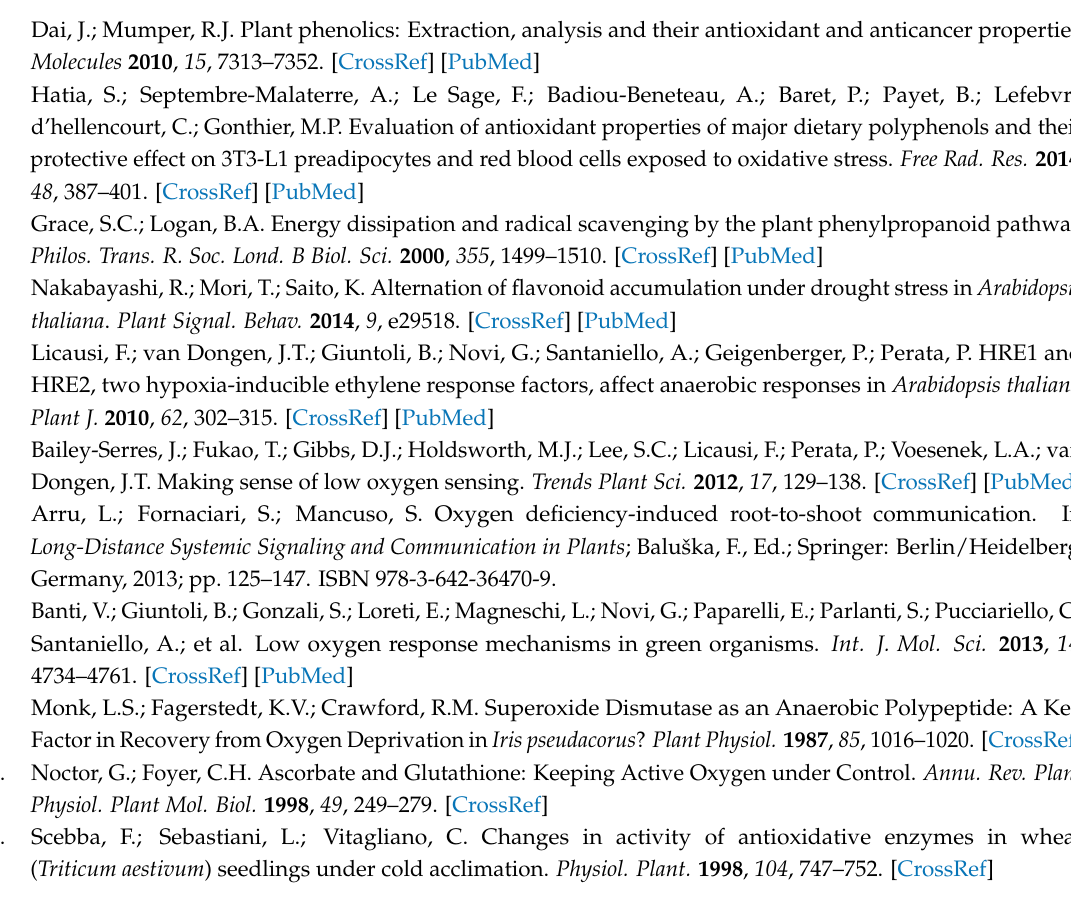
Table S1: Monitoring of changes in O 2 levels in the nutrient solution. Figure S1: LC-MS profile of the extract. Figure S2: Negative mode ESI-MS spectra. Figure S3: Comet